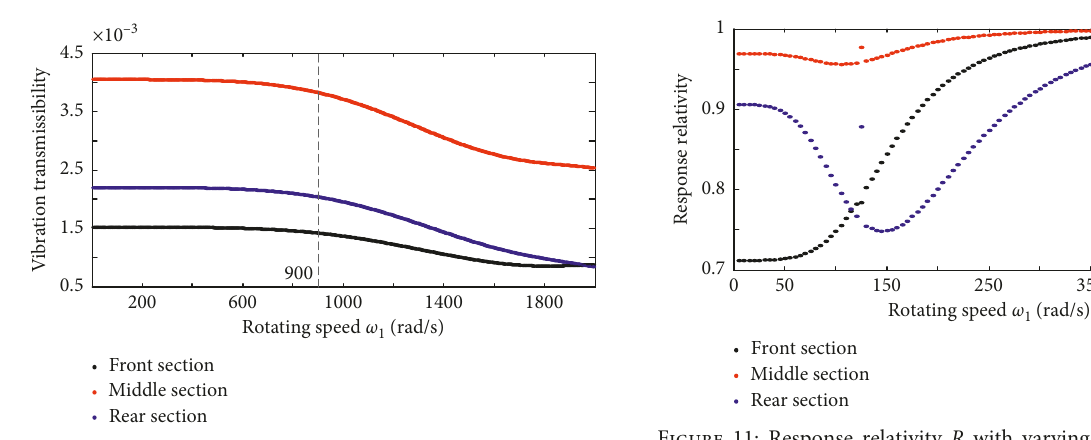
Figure 9: Vibration transmissibility ξ with varying rotating speed of low-pressure rotor ω l : front section (black), middle section (red), and rear section (blue).